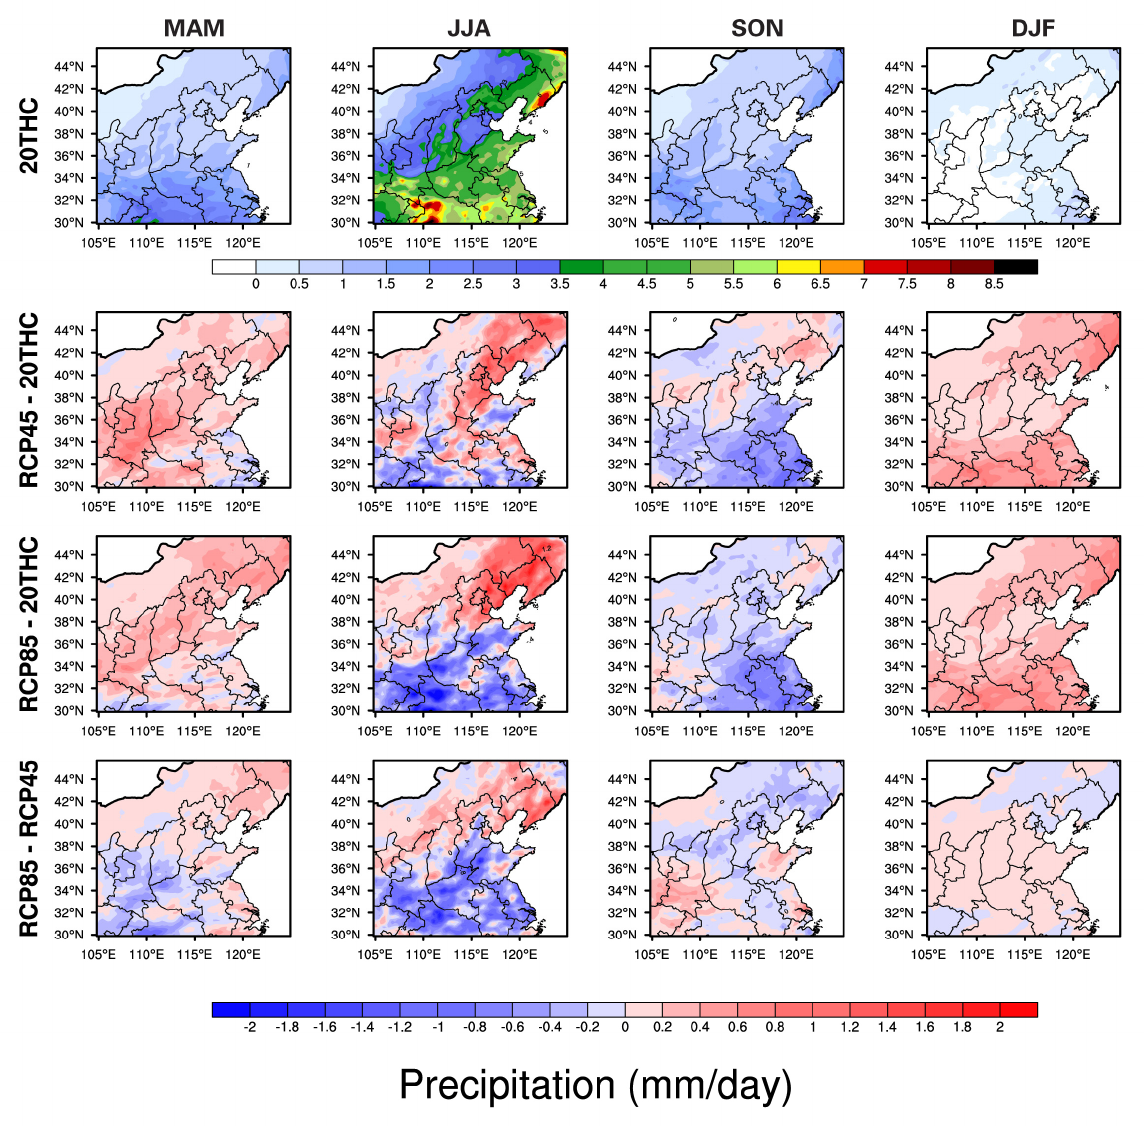
Figure 8. Projection of precipitation in MAM, JJA, SON, and DJF. Changes in precipitation which are represented the RCP4.5 minus 20THC, RCP8.5 minus 20THC, and RCP8.5 minus RCP4.5.